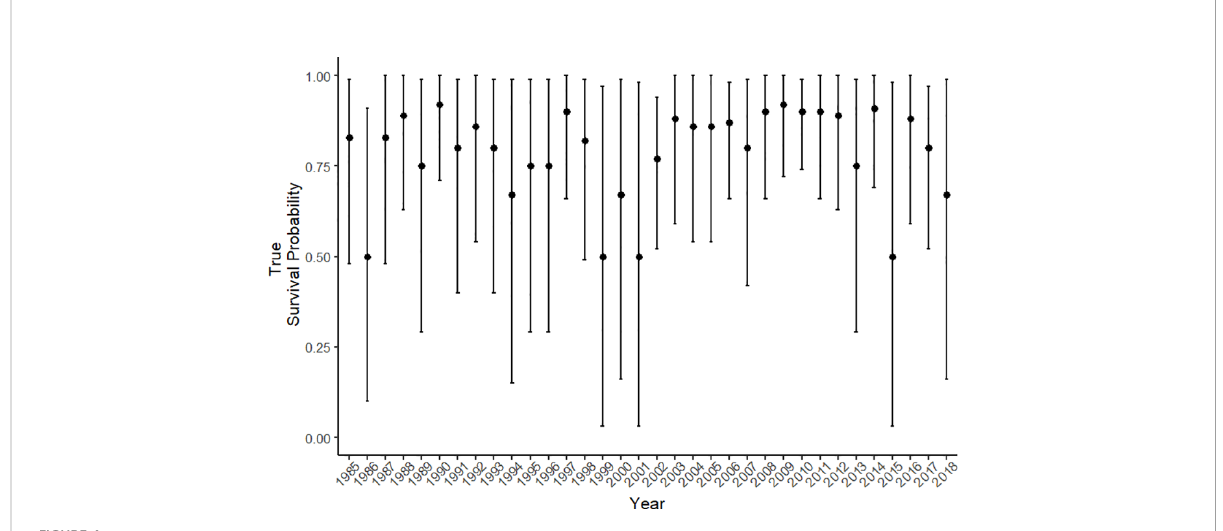
FIGURE 4 The true survival probability for calves from 1985 – 2018. Error bars represent the 95% credible